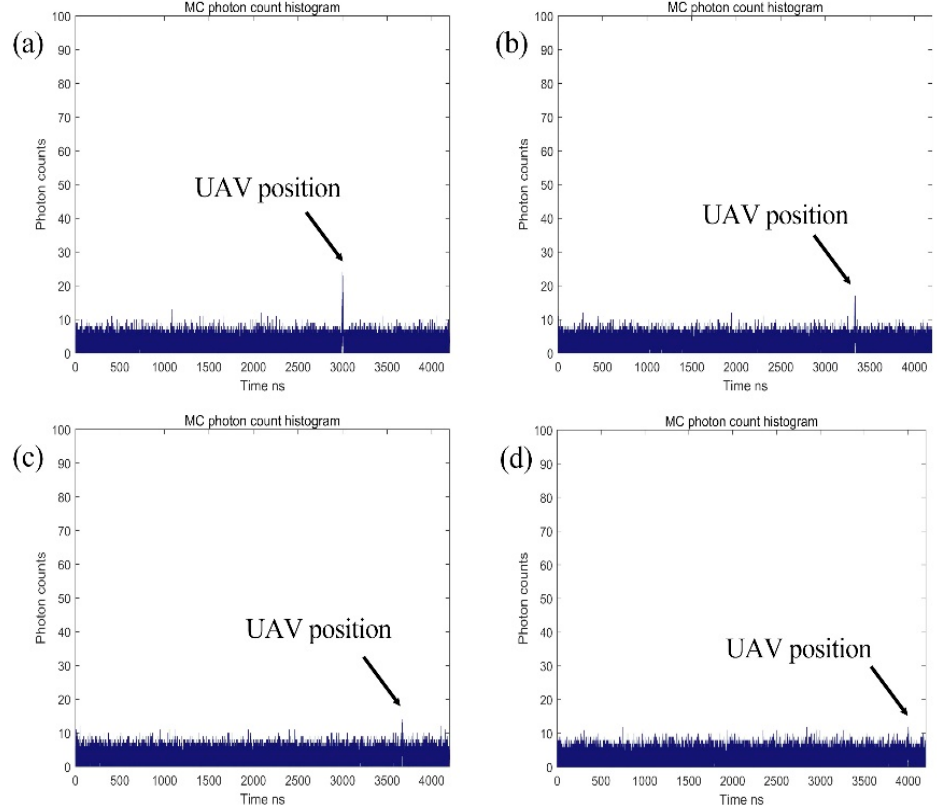
Figure 6. At the FOV of 32 mrad, the UAV was located at ( a ) 450 m, ( b ) 500 m, ( c ) 550 m, ( d ) 600 m.